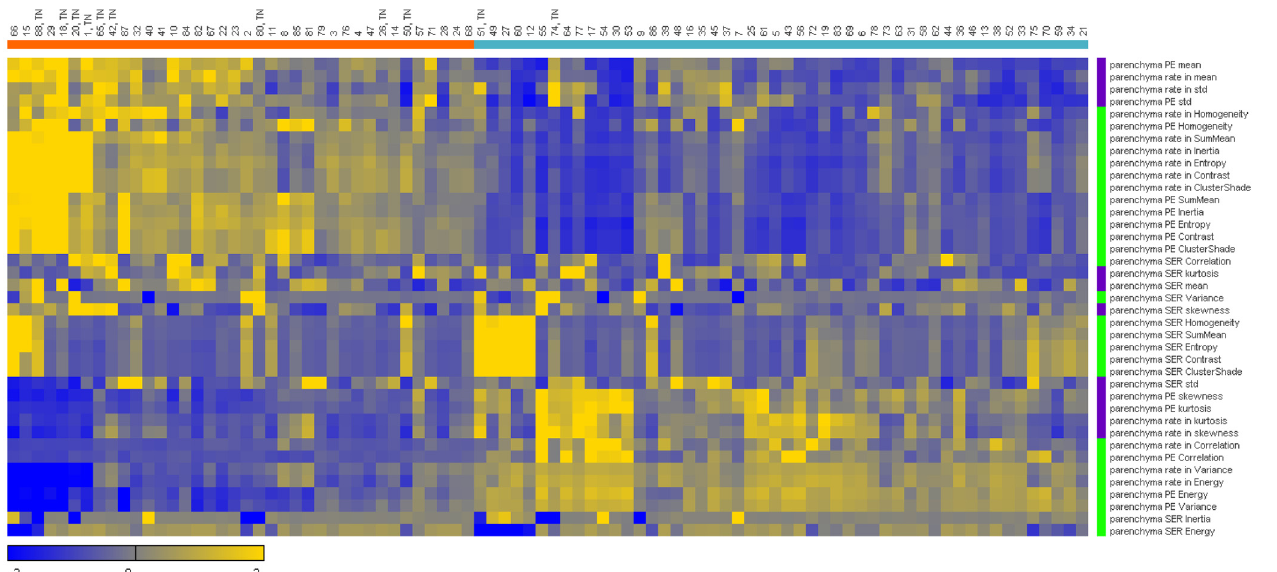
Fig 5. Unsupervised k -means clustering of breast cancer patients (n = 88) on the x-axis and quantitative background parenchymal enhancement (BPE) feature expression (n = 39) on y-axis (as z-scores, with scale at bottom left. std = standard deviation). Correspondence of patient groups with similar radiomic expression patterns can be seen where the majority of triple-negative (TN) breast cancers have grouped together in the left cluster (9 of 11 TN in partition highlighted orange at top left) due to association of the BPE heterogeneity feature signatures. 1 st order statistical texture features are highlighted as purple and similarly 2 nd order statistical texture features are green at right indicating correspondence of feature groups with clustered expression patterns.